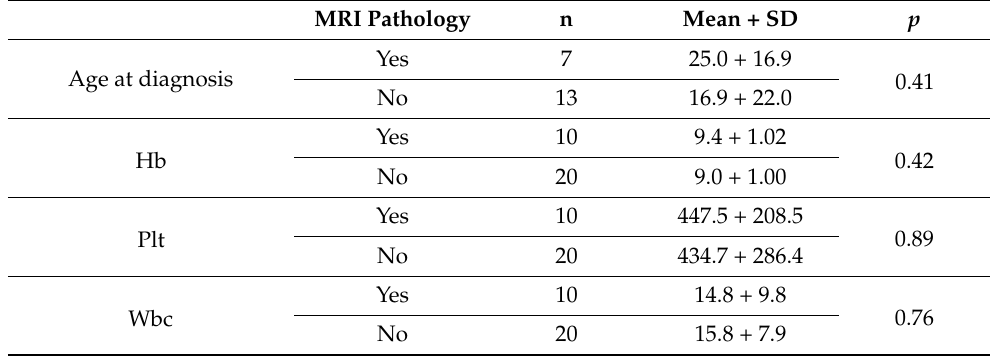
Figure 1. ( a – c ): Axial T2 ( a ) and Axial FLAIR ( b ) weighted images show multiple foci of hyper- intensity that are related to asymptomatic brain ischemia. Axial FLAIR ( c ) image show widened epidural tissue. Table 4. Comparison of patients with and without pathology on